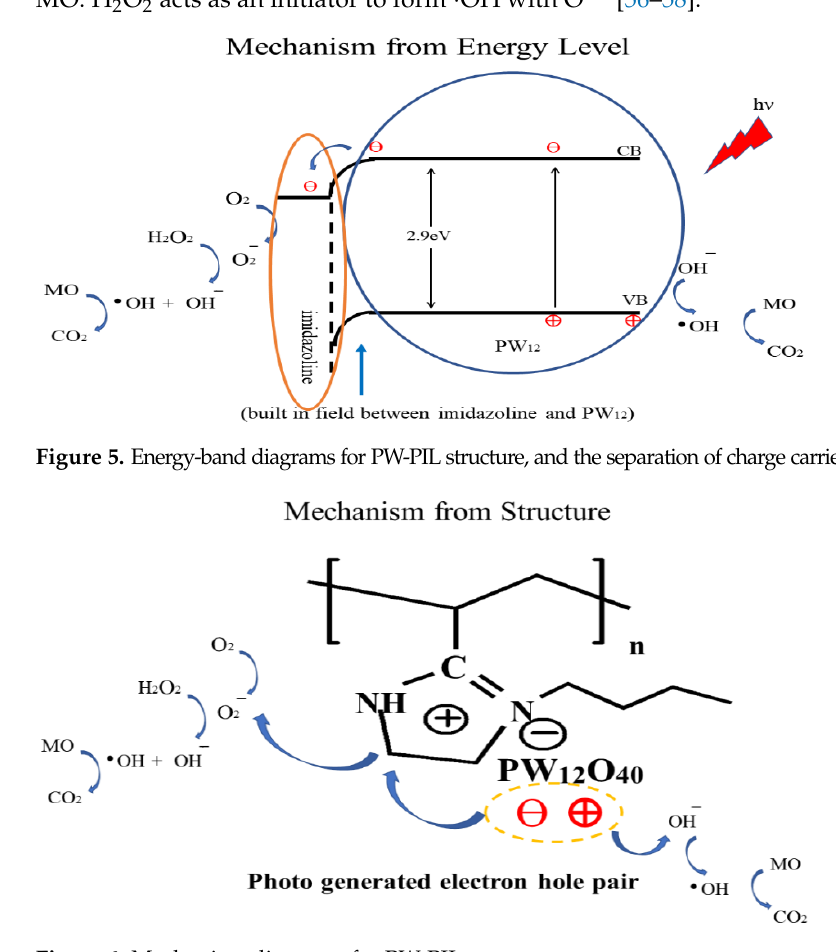
Figure 6. Mechanism diagrams for PW-PIL structure.